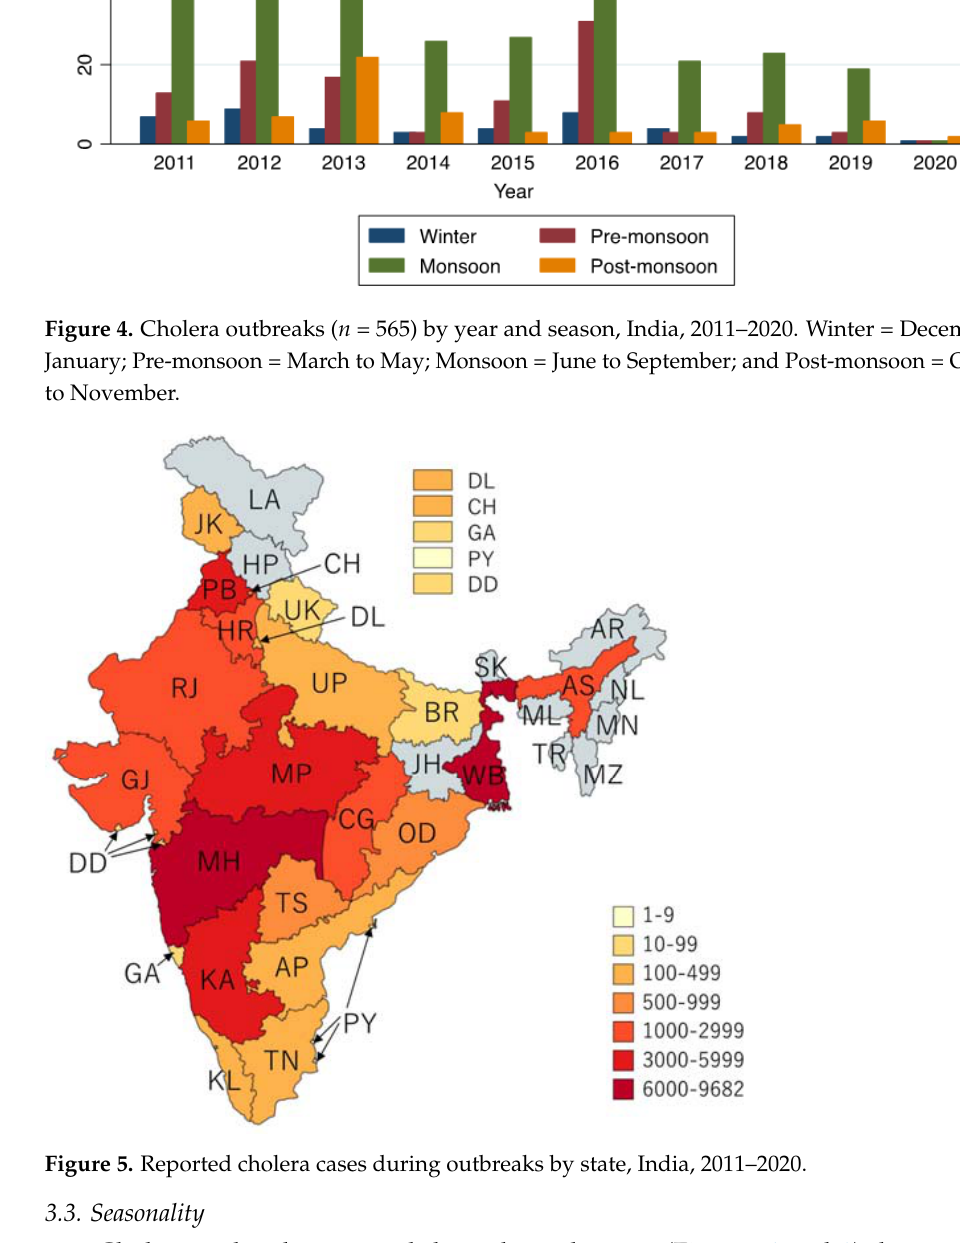
Figure 5. Reported cholera cases during outbreaks by state, India, 2011–2020.